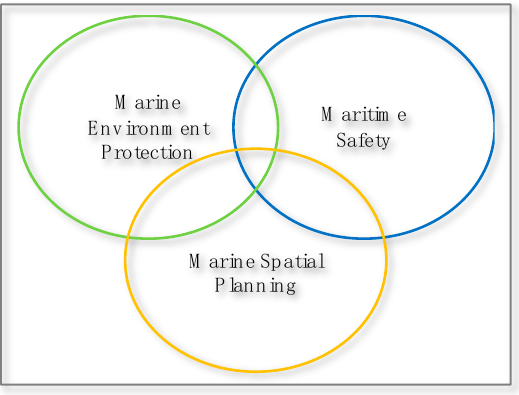
Figure 2. Marine information domains.